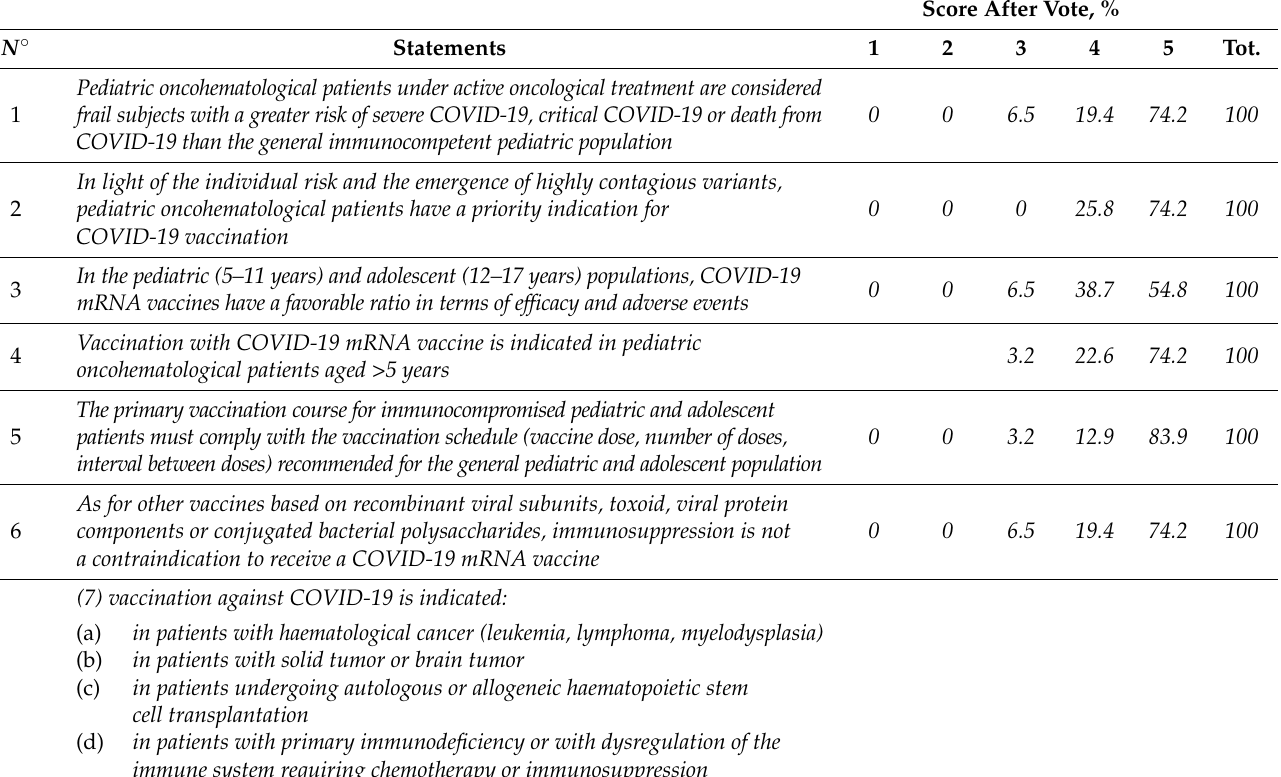
Table 1. List of statements and the aggregate score of the vote of the Centers.